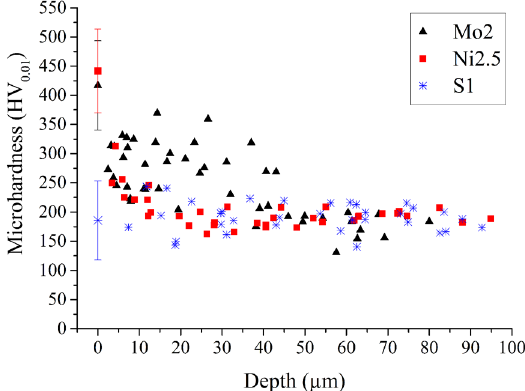
Figure 5. Microhardness profiles of the cross-section of the specimens. The surface microhardness values of the samples Mo2 and Ni2.5 were very similar, 416.8 ± 76.9 and 441.9 HV ± 72.0 HV, respectively. The error bars means the standard deviation of microhardness.